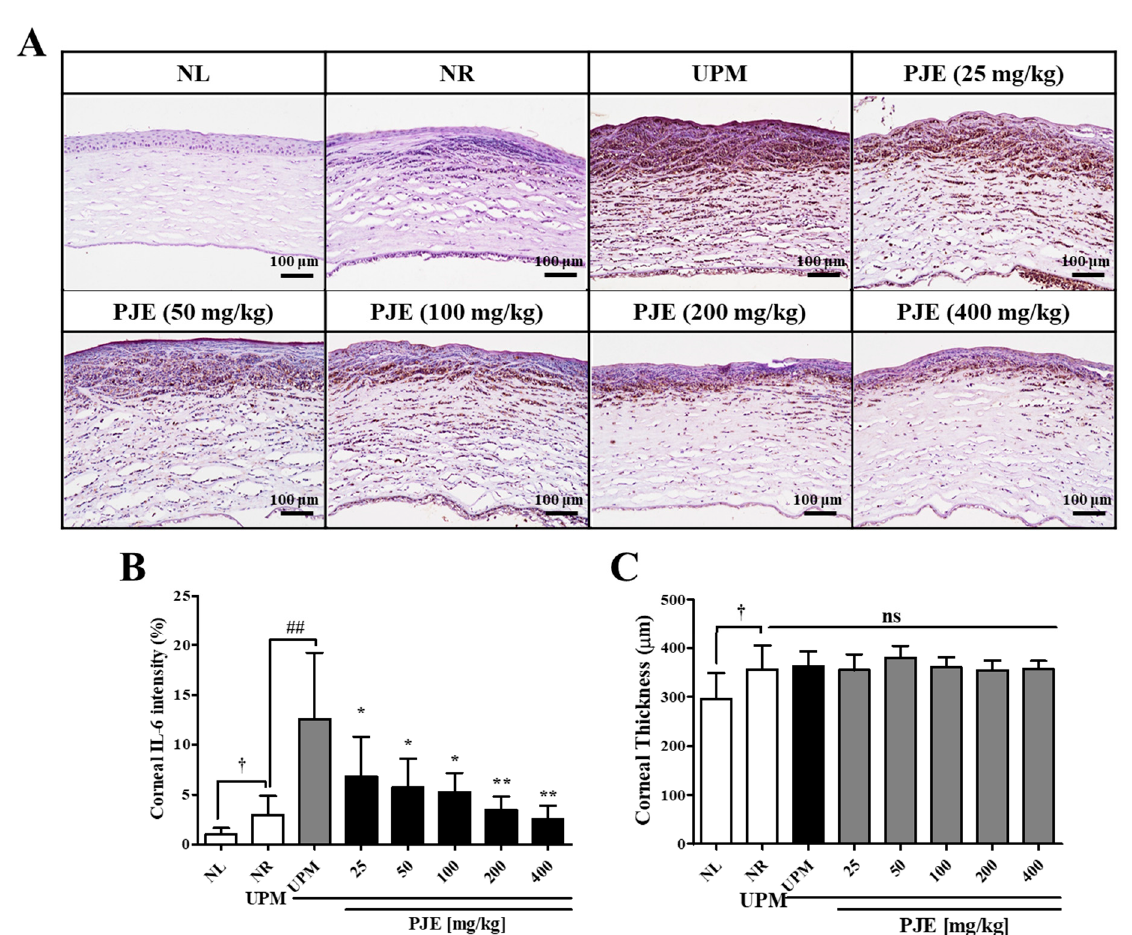
Figure 7. Immunohistological changes in IL-6 expression during corneal wound healing after treatment with PJE and after UPM exposure. ( A ) Immunohistochemical staining images for IL-6 in the corneas after 72 h were acquired at 200× magnification, and representative images are shown. ( B ) The intensities of the stained areas were calculated and the data are presented as the means ± SD. ( C ) The corneal thicknesses were calculated and are presented as the means ± SD. † p < 0.05 compared to NL; ## p < 0.01 compared to NR; * p < 0.05, ** p < 0.01 compared to UPM; ns, not significant.